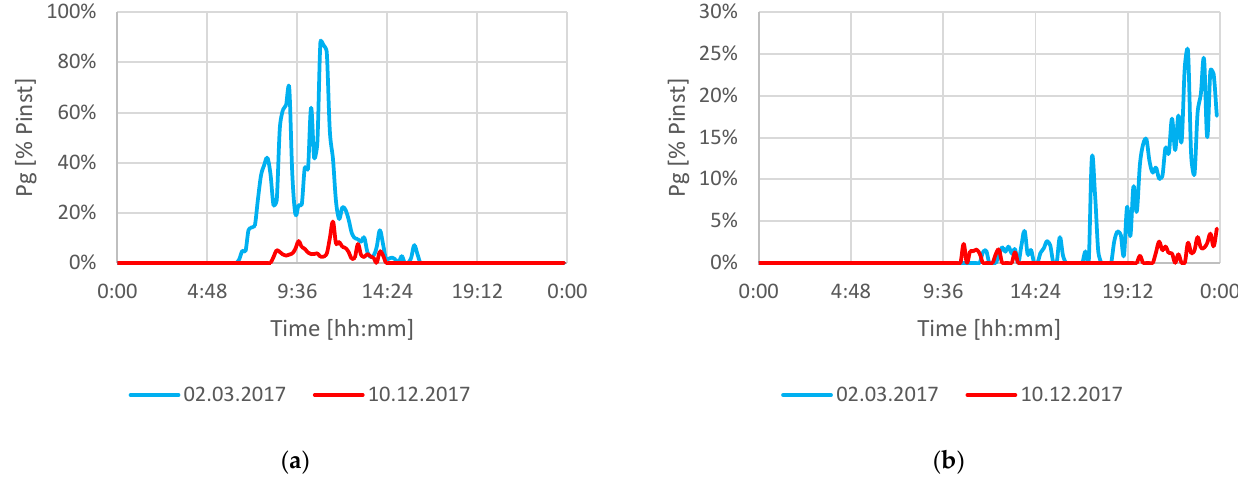
Figure 6. ( a ) Daily generation capacity charecteristics of photovoltaic sources; ( b ) Daily generation capacity characteristics of wind microturbine generation sets.